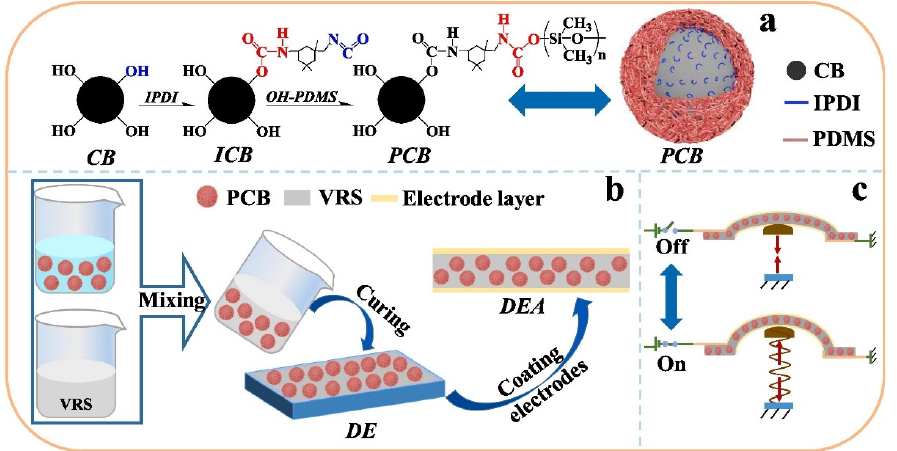
Figure 7. ( a ) Illustration of the formation of PCB particles. Catalyzed by DBTDL, hydroxyl group of CB surface initially crosslinks with IPDI to produce a N=C=O group functionalized CB, then couples with OH-PDMS, thus coating a layer of PDMS film to CB surface. ( b ) Illustration of the fabrication of DEA. The PCB particles are filled in VRS precursor and cured to produce a PCB/VRS hybrid film. The conductive silicone paste is brushed on both PCB/VRS film surfaces to make a trilayer DEA. ( c ) Prestrained by an elastic spring, the hybrid DEA takes an out ‐ of ‐ plane actuation under a pulse elec ‐ trical field. Reprinted/adapted with permission from Ref. [28]. 2022, Elsevier. In general, the pros of the actuators based on dielectric elastomer EAPs are their large displacements of strain up to 200–380%, high energy density (3.4 J/g) [15,29], fast response (maximum contraction frequency can reach 1000 Hz) [30], and being considered cheap.